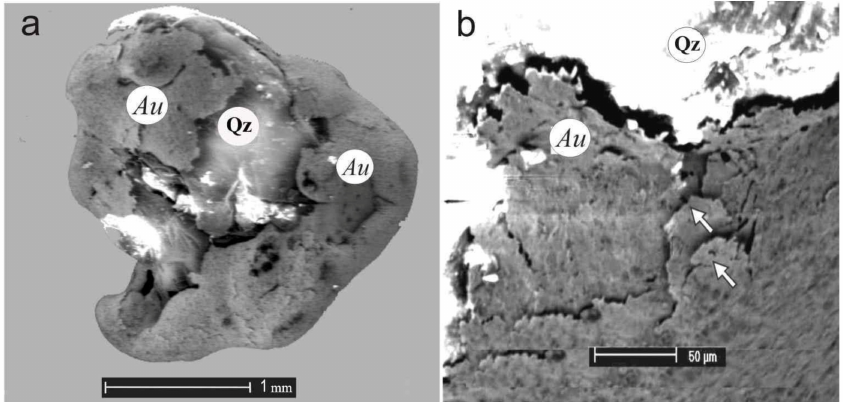
Figure 8. Gold-encrusted quartz obtained as a result of blows with grains of sand and intergrowth of native gold with quartz in an experimental facility: ( a ) general view; ( b ) detail, the filmy-fibrous surface of gold (shown by arrows); Au = gold; Qz = quartz.